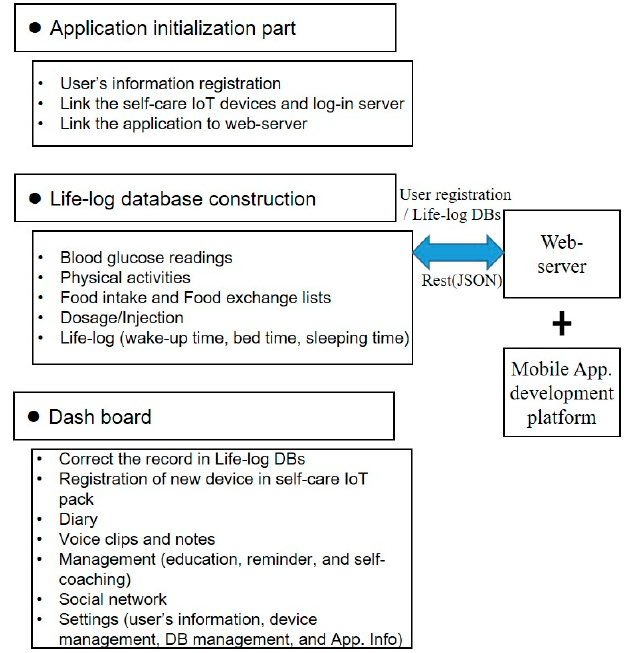
Figure 7. The mobile application of a proposed self-care platform. (Rest: Representational state transfer, JSON: Javascript object notation).